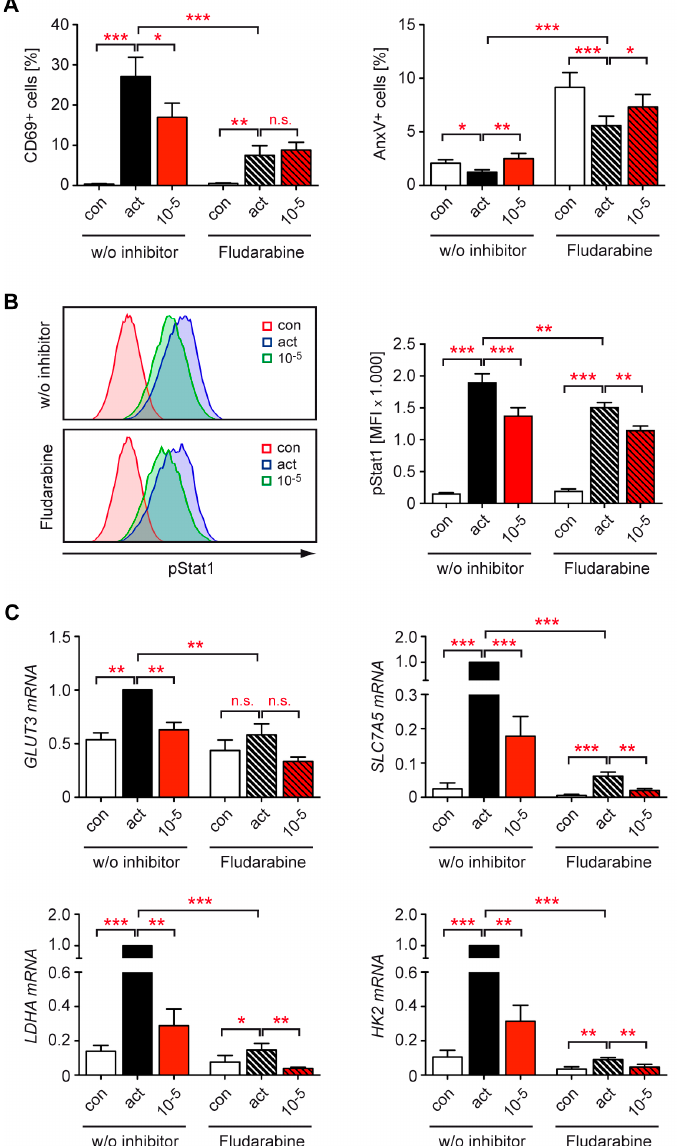
Figure 5. Role of Stat1 signaling for the repressive activity of Dex on T cell function and metabolic gene expression in human peripheral blood T cells. ( A ) T cells were purified from buffy coats of healthy human donors and stimulated with hCD3 ε and hCD28 antibodies for 20 h in the absence (act) or presence of 10 − 5 M Dex. Unstimulated T cells served as a control (con). To study the role of Stat1, fludarabine was added at a concentration of 50 μ g/mL to the same experimental setup. The percentages of CD69 + and AnxV + CD3 + CD4 + T cells were determined by flow cytometric analysis. N = 10/12. ( B ) T cells were treated as in panel A. After extracellular staining for CD3, CD4, and CD69, the cells were fixed, permeabilized, and then intracellularly stained for pStat1 (Tyr701). Analysis was performed by flow cytometry. Exemplary overlay histograms of pStat1 stainings of CD4 + T cells (con) or CD4 + CD69 + T cells (act, 10 − 5 M Dex) are depicted in the left panel. The mean fluorescence intensity (MFI) of pStat1 for CD4 + T cells (con) or CD4 + CD69 + T cells (act, 10 − 5 M Dex) is depicted in the right panel. N = 6. ( C ) Expression of metabolic genes was determined by RT-qPCR. N = 7. Relative mRNA levels were calculated by normalization to the housekeeping gene 18SRNA . Expression in activated T cells was arbitrarily set to 1. Values are depicted as the mean ± SEM. Statistical analysis was performed by one-way ANOVA followed by a multiple comparisons test. Levels of significance: ∗ p < 0.05; ∗∗ p < 0.01; ∗∗∗ p < 0.001; n.s.: p > 0.05.